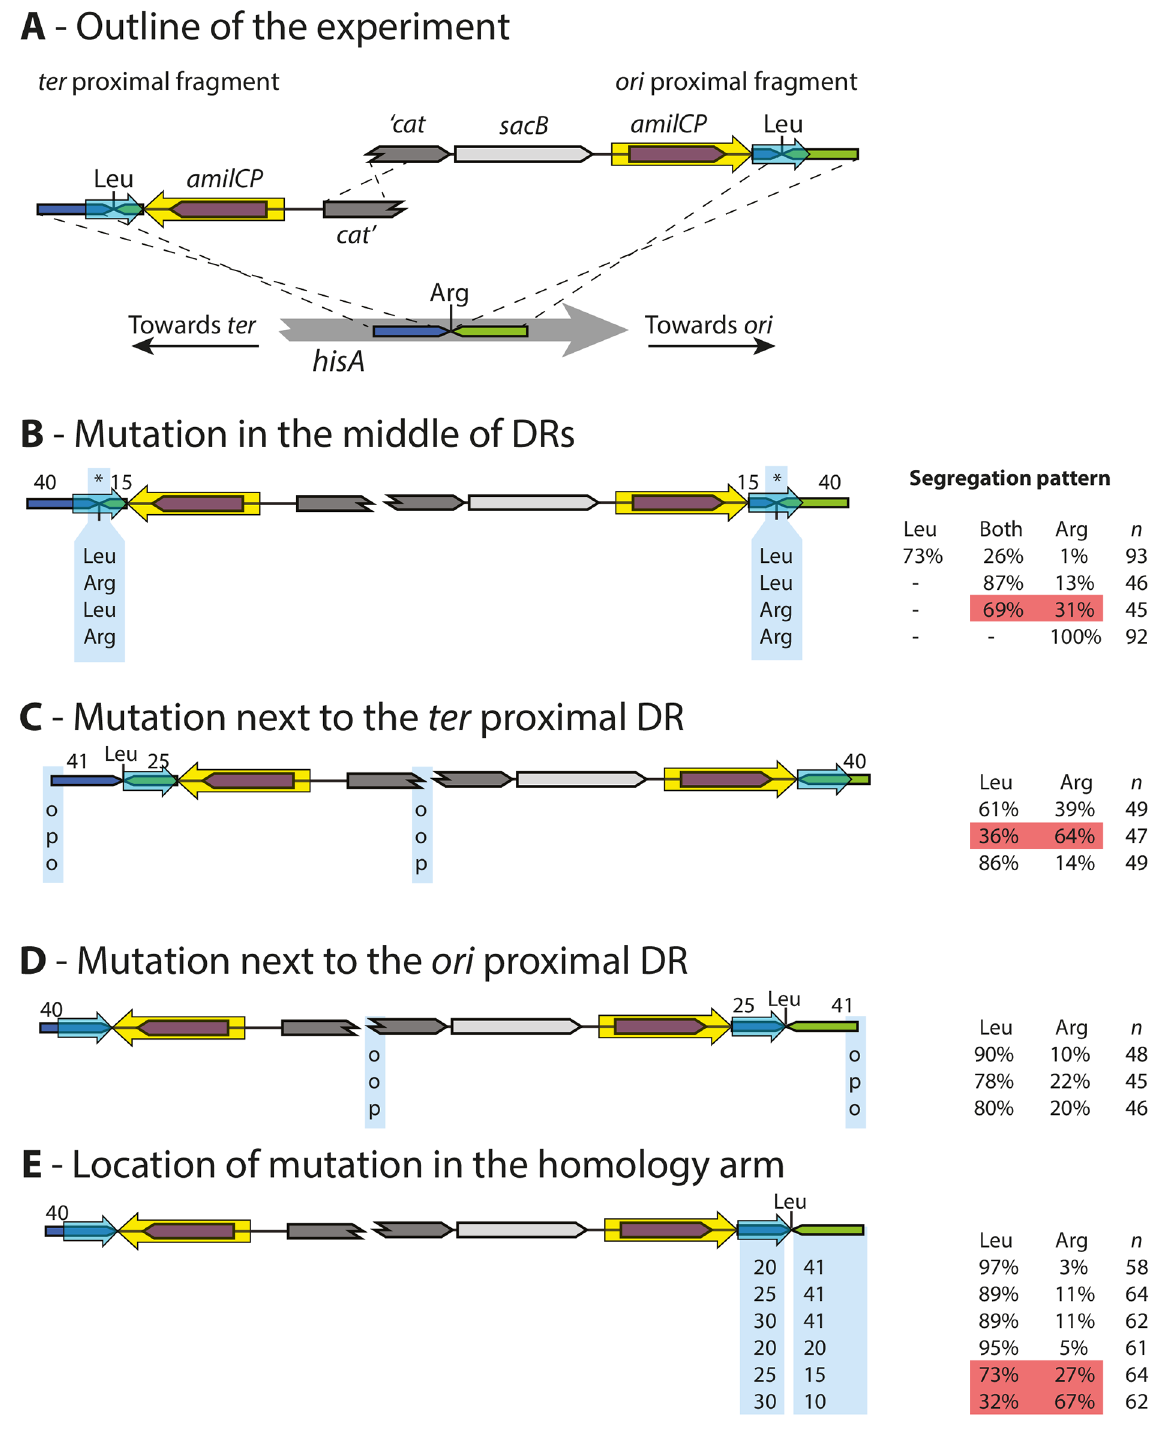
Fig 6. Alternative strategies for generating point mutations with DIRex. (A) Schematic view of the recombineeringused for these tests. The recipientstrain carries a L169Rmutation in hisA , renderingit His - (but Trp + ). The incomingPCR fragments are designed to repair this mutation, making the wanted transformants (after segregation of the cassette) His + (but Trp - ). (B) Constructs with the mutation in the middle of the DRs. The site of the mutation is indicatedin both DRs with asterisks. “Leu” and “Arg” belowthe DRs indicate which allelewas present in the corresponding PCR product. In the table to the right, “Leu” indicatesthe fraction of transformants that only segregated to the L169 (wanted)allele, “Both” the fraction of transformants that segregated to both alleles,